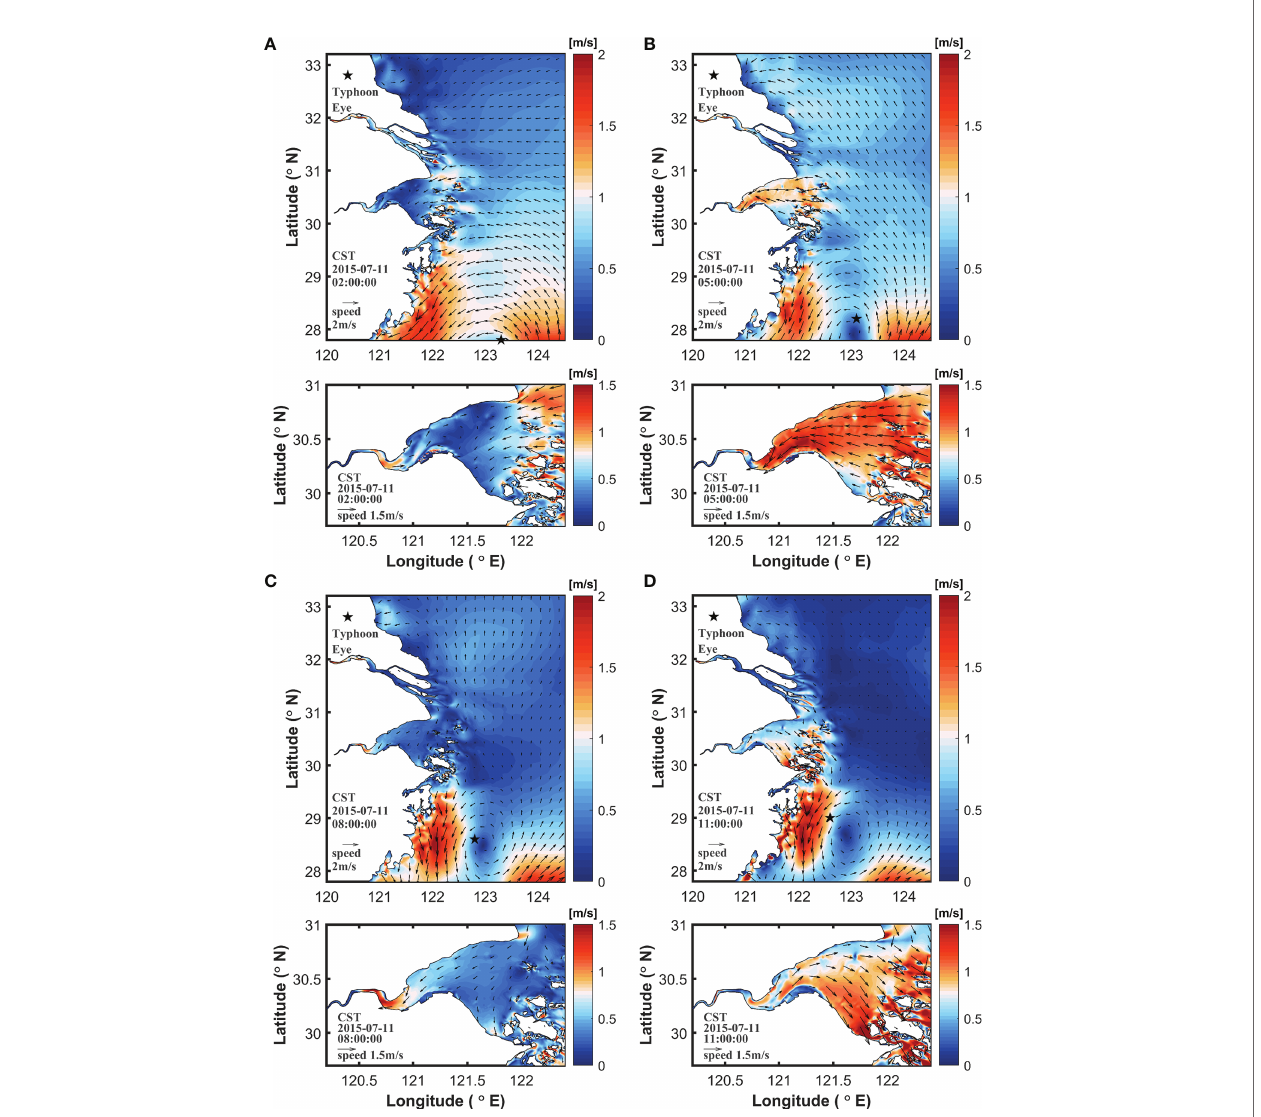
FIGURE 5 | Surface fl ow fi eld at (A) 02:00, (B) 05:00, (C) 08:00 and (D) 11:00 on July 11, 2015